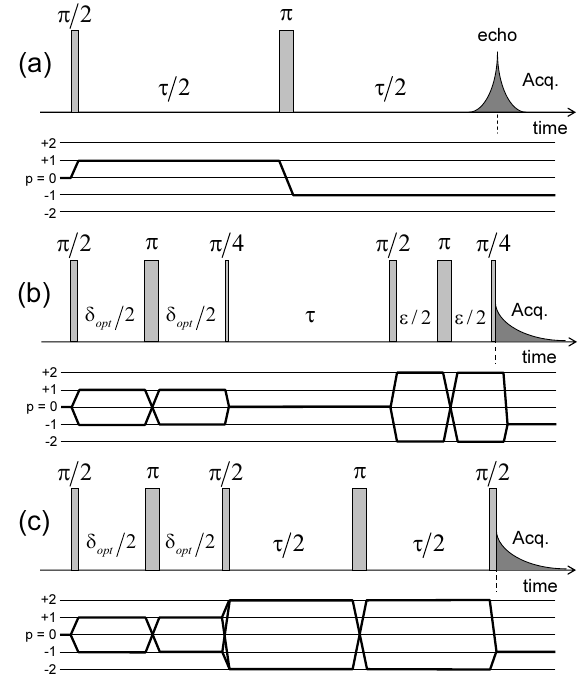
Figure 4. Pulse sequences and coherence transfer pathways used to measure the NMR relaxation rates of: ( a ) T 11 ( a , s ) ; ( b ) T 20 and ( c ) T 22 ( a , s ) coherences (see the Appendix C). The delay δ opt is selected to optimise the coherence tranfer, and the delay (cid:101) is set equal to 10 µ s. Reprinted with permission from [23]. Copyright (2014) American Chemical